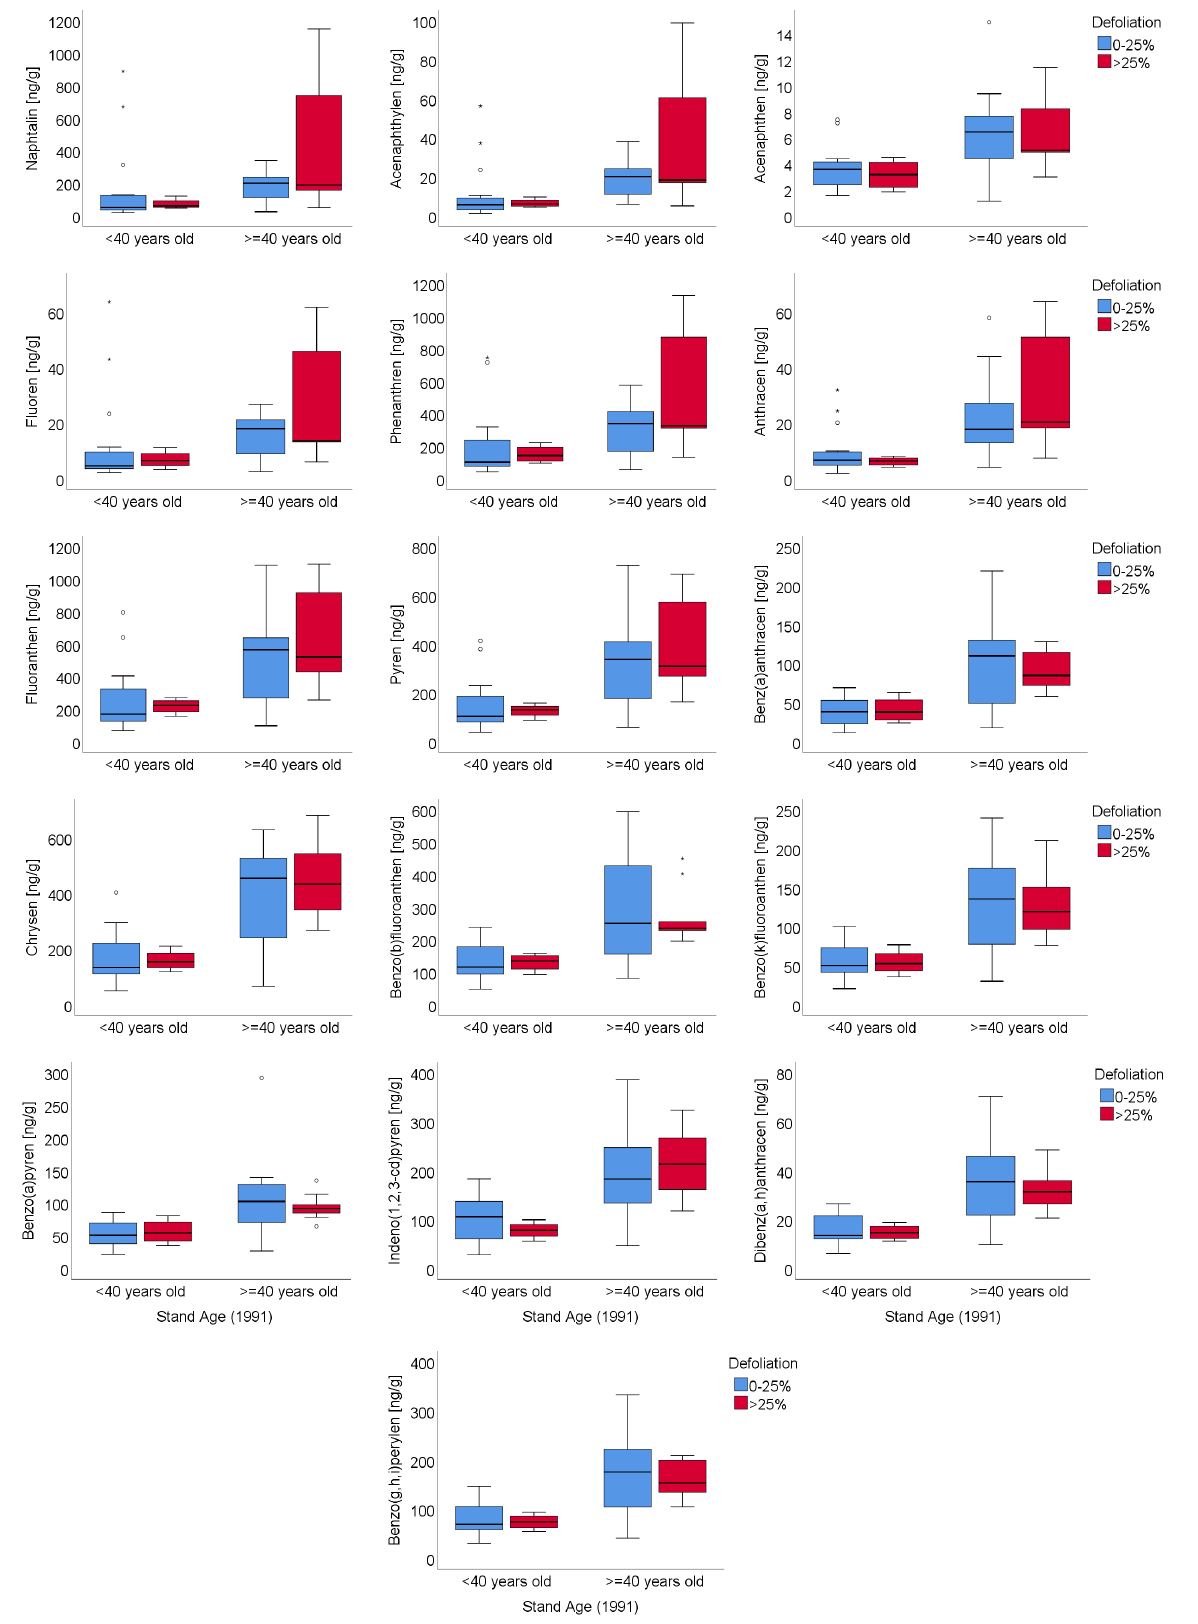
Figure 7. Box plots of the content of the PAH 16 from individual analytes in the humus layer of pine stands differentiated according to stand age and crown condition (percentage needle loss); ° outliers, * extreme